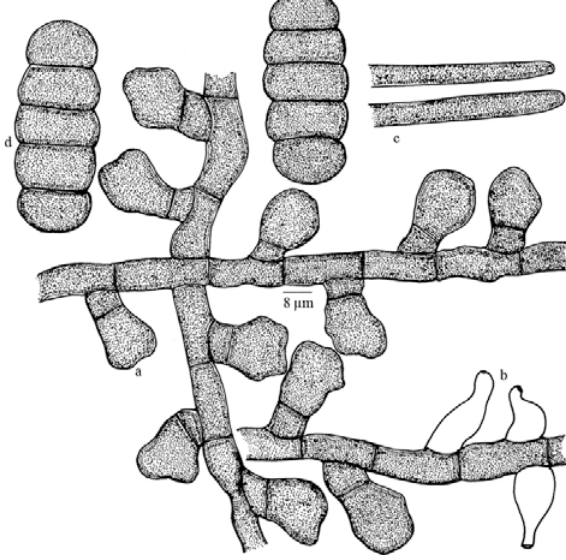
Figure 27. Irenopsis hiptages var. indica a - Appressorium; b - Phialide; c - Apical portion of the perithecial setae; d - Ascospores